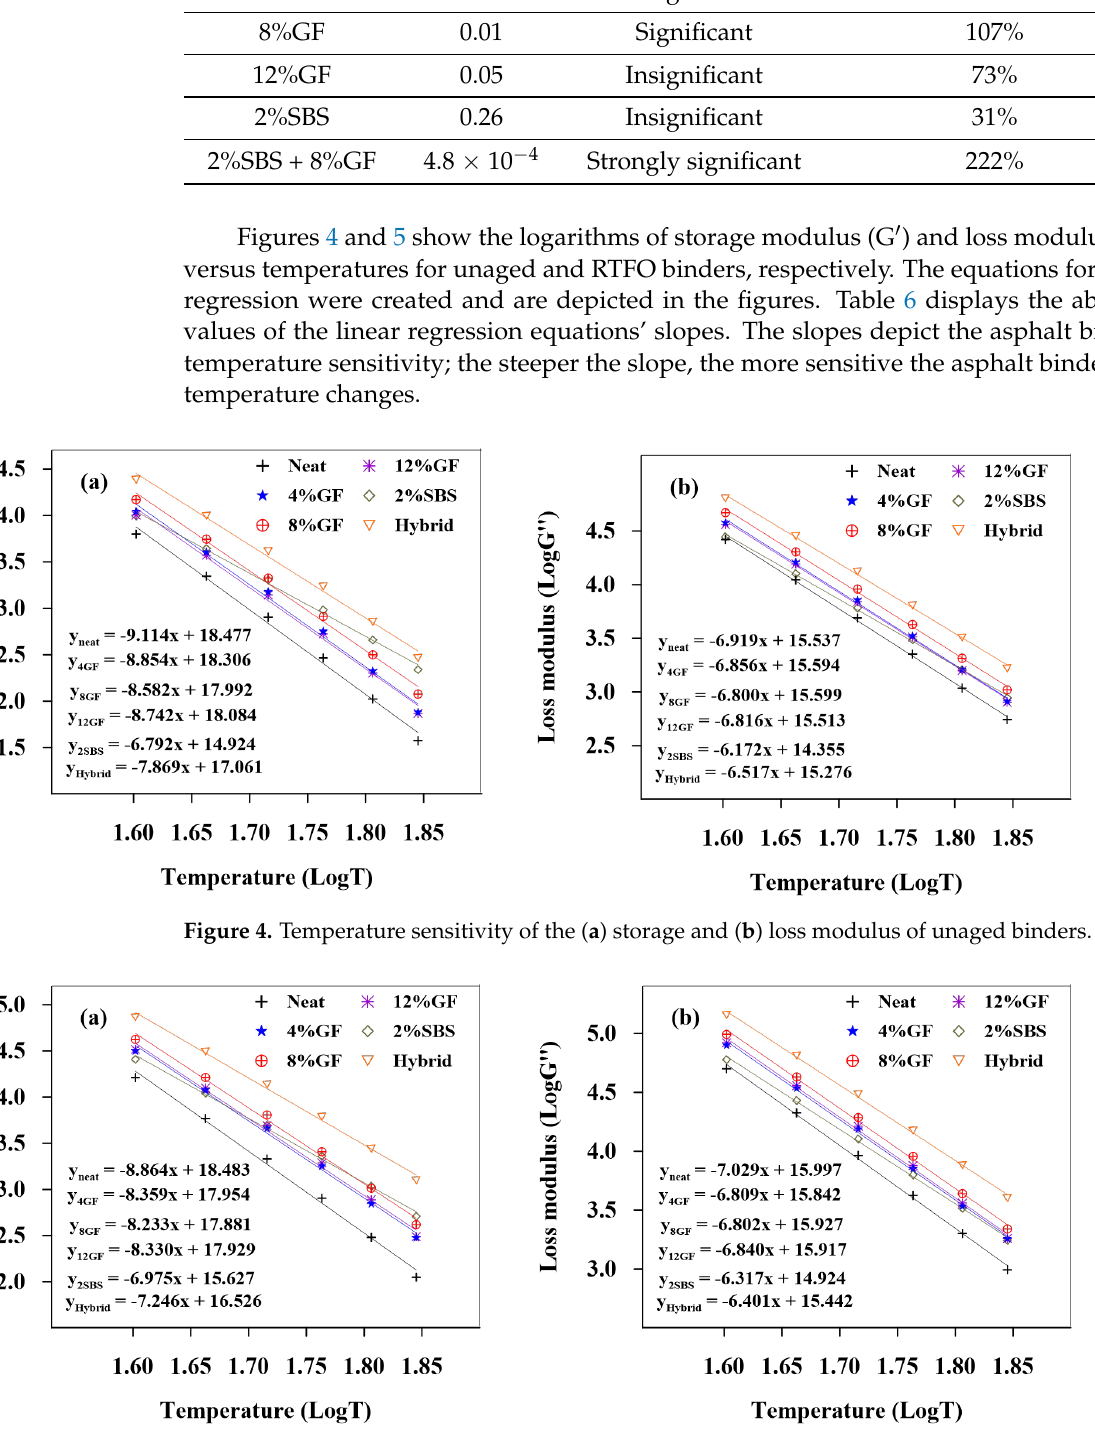
Figure 5. Temperature sensitivity of the ( a ) storage and ( b ) loss modulus of RTFO